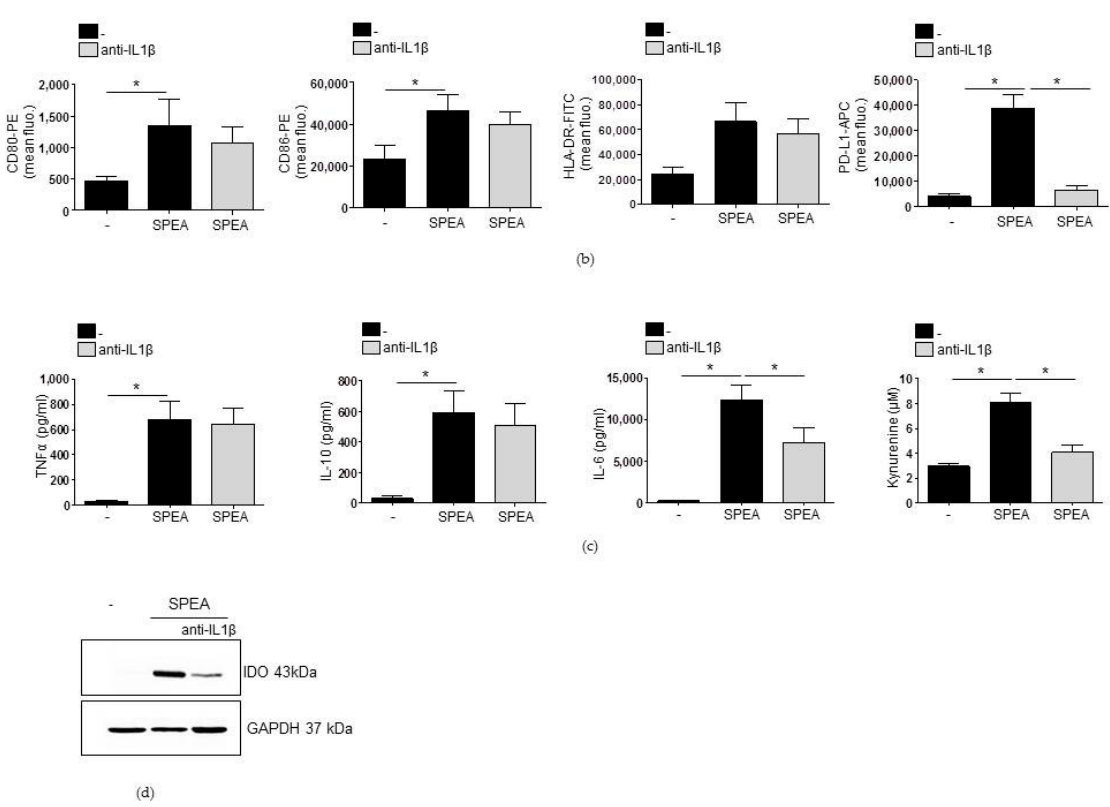
Figure 5. SPEA-stimulated induction of PD-L1 and kynurenine depends on IL-1 β . Primary monocytes were stimulated with 1000 ng / mL SPEA +/ − anti-IL-1 β neutralizing antibody (3 µ g / mL) for 48 h. Antibody staining was performed with anti-CD80-PE, anti-CD86-PE, anti-HLA-DR-FITC and anti-PD-L1-APC antibodies. Fluorescence was analyzed on a FACSCanto. ( a ) Histograms of antibody staining. Upper row: fluorescence signal of unstained, pooled monocytes. Middle row: data of SPEA-monocytes. Bottom row: data of SPEA-monocytes + anti-IL-1 β . ( b ) Quantification of mean fluorescence of ( a ) and two more experiments. ( c ) Supernatant of cells was used for ELISA analyses. ( d ) Western blot analysis of IDO and GAPDH (loading control) of SPEA-stimulated monocytes (48 h) +/ − anti-IL-1 β neutralizing antibody. ( b , c ): Black columns: culture without anti-IL1 β antibody. Grey columns: with supplemented anti-Il-1 β . Shown is the mean + SD, n = 3. The comparison of two data groups was analyzed by Mann–Whitney U test with * p ≤ 0.05. The lines above the columns depict the compared groups. Kruskal–Wallis for ( b , c ): number of groups: 3; CD80, CD86, HLA-DR: p -value 0.0509; sum value, n.s. TNF, IL-10: p -value 0.0608; sum value (CD80, CD86, HLA-DR, TNF, IL-10), n.s. PD-L1, kynurenine: p -value 0.0147. IL-6: p -value 0.0390, sum value (PD-L1, kynurenine, IL-6), * the medians vary significantly ( p < 0.05).